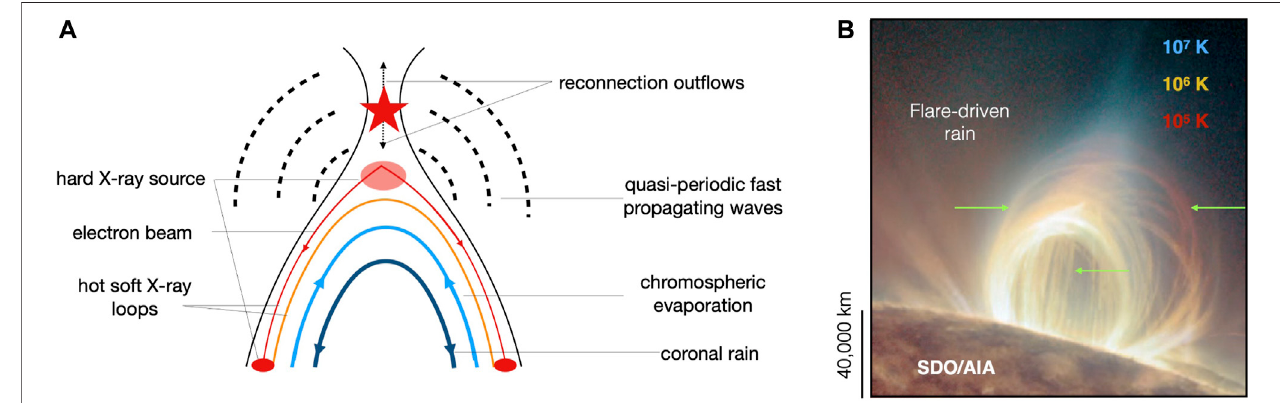
FIGURE 14 | Flare-driven coronal rain and its place in the standard fl are model. (A) Sketch of the standard fl are model, with the reconnection region depicted as a redstarinthecorona.Severaloftheusuallyobservedprocessesduringa fl areareindicated. (B) M7.7class fl areobservedby SDO /AIAon19July2012,ontheWestlimb of the Sun. The composite image shows AIA/94 in blue (10 7 K), AIA/171 (10 6 K) and AIA/304 (10 5 K) in the gradual phase of the fl are, where coronal rain (indicated by green arrows) can be observed tracing a dome-like